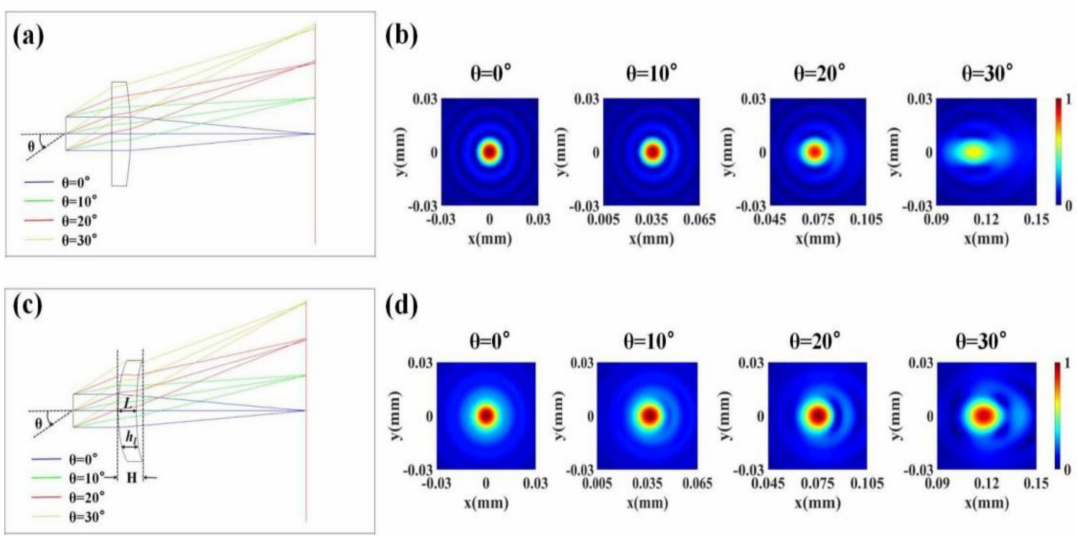
Figure 1. ( a , c ) The focusing effect of the lens ( a ) without and ( c ) with monochromatic aberration corrected at different incident angles. The blue, green, red, and yellow lines represent the propagation trajectories of rays with incident angles θ = 0 ◦ , 10 ◦ , 20 ◦ , and 30 ◦ , respectively. L in ( c ) is the thickness at the center of the lens, hl represents the actual thickness at different positions of the lens, and the total thickness of the system is denoted by H. ( b , d ) The electric field intensity distributions at the focal plane of the lens ( b ) without and ( d ) with monochromatic aberration-corrected at different incident angles. All electric field intensity profiles are normalized. The focal points are all placed in the central area of the images, and the actual x-direction offset is used to distinguish different incident